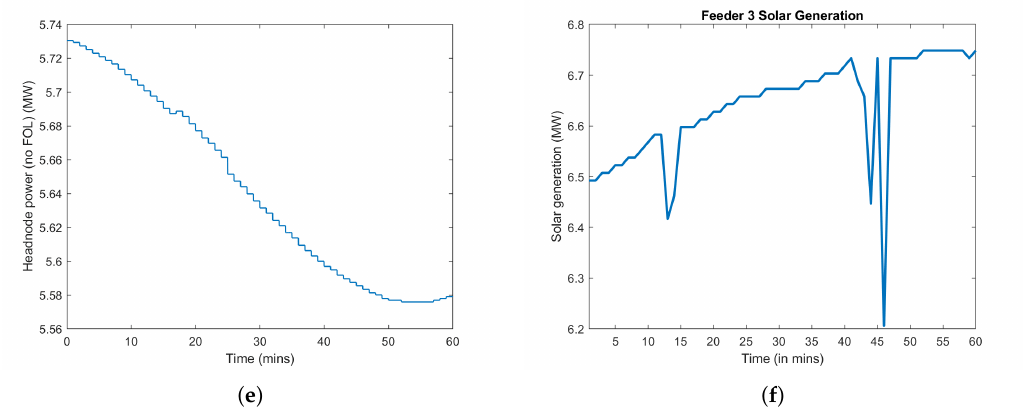
Figure 15. Total nominal active power demand and supply at the headnode of each feeder. ( a ) Feeder 1